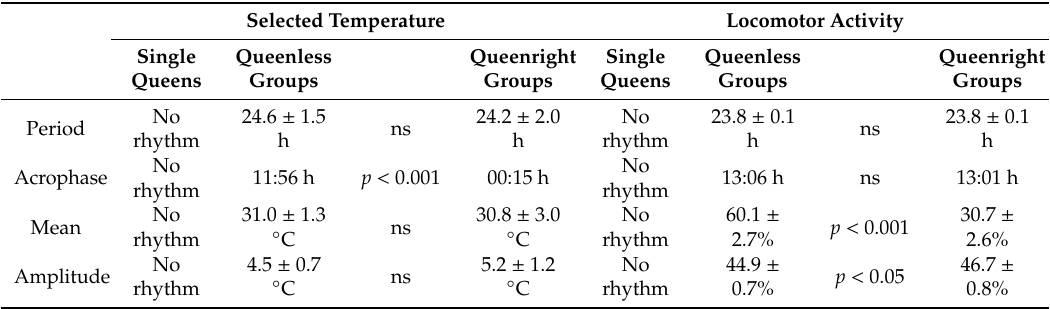
Table 1. A comparison of the period, acrophase, mean, and amplitude of the rhythms of the selected ambient temperature and locomotor activity in single queens and in queenless and queenright groups of worker bees. Selected Temperature Locomotor Activity Single Queenright Single Queenless Queenright Queens Groups Queens Groups